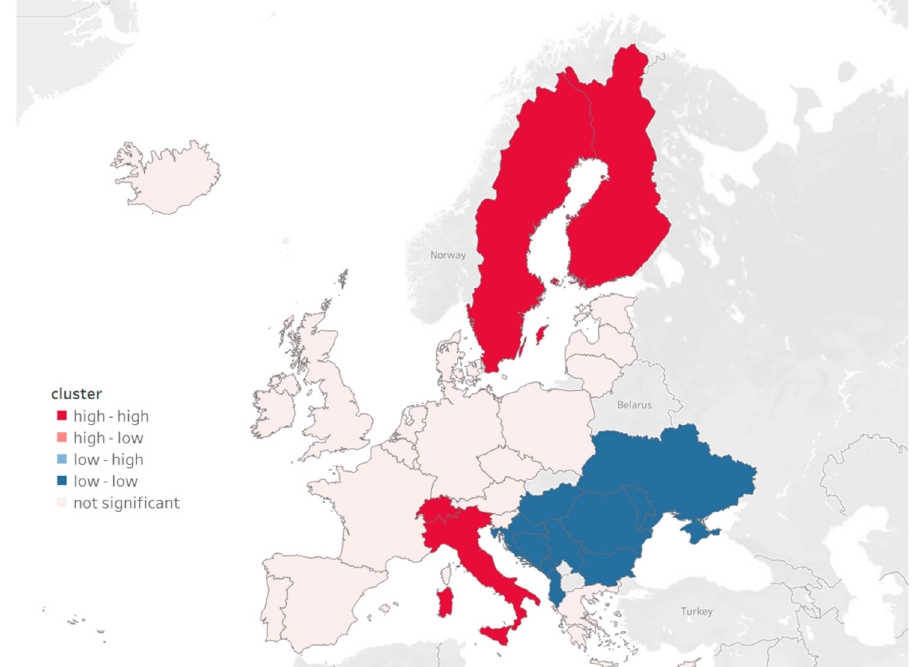
Figure 8. ETI cluster map in Europe.